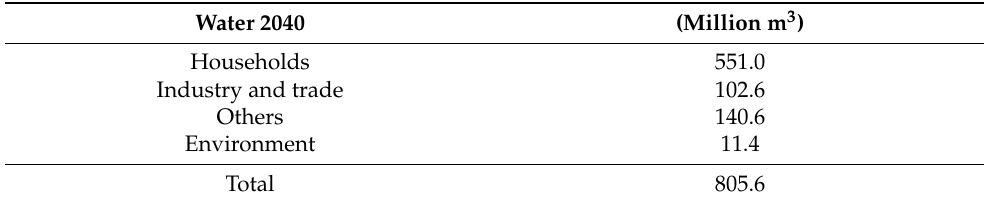
Table 7. Estimated water consumption in Berlin in the year 2040, author’s work based on water supply concept for Berlin